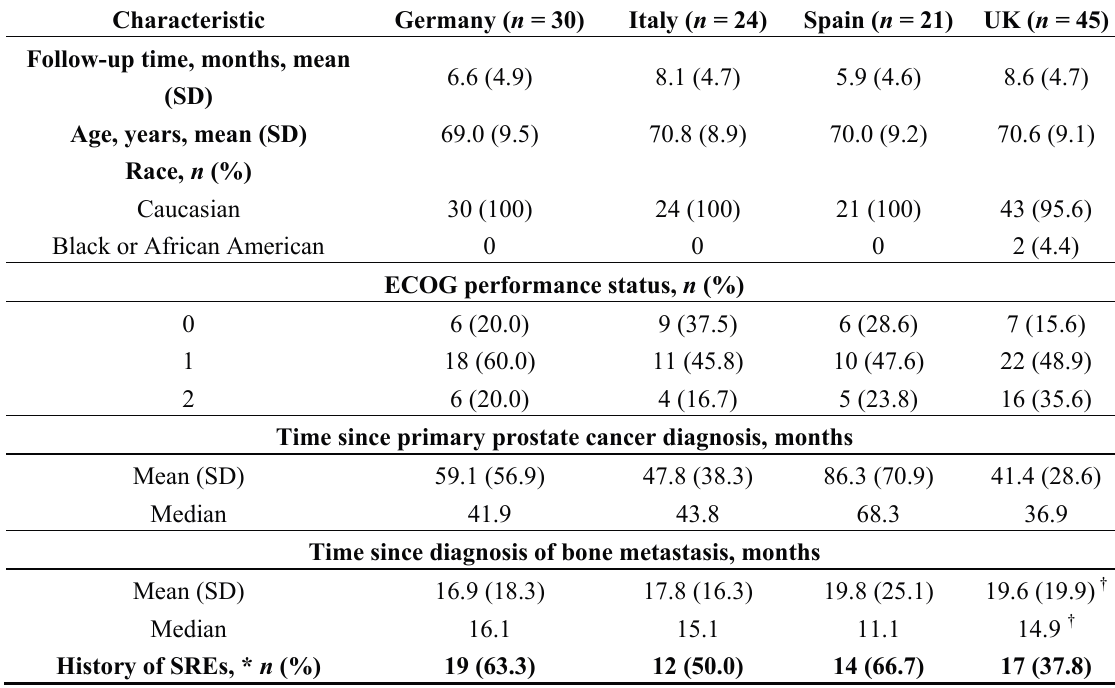
Table 1. Baseline patient demographics and disease history. Characteristic Follow-up time, months,